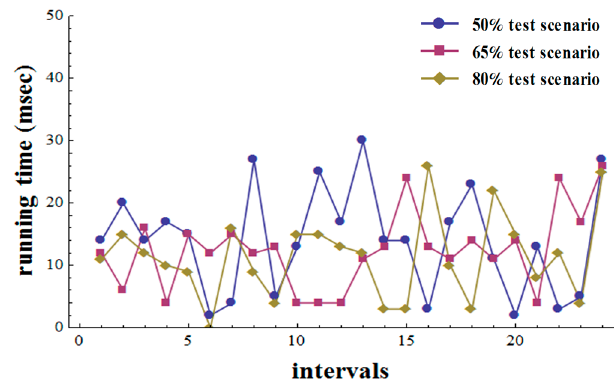
Figure 8. Running time of our load shedding system.